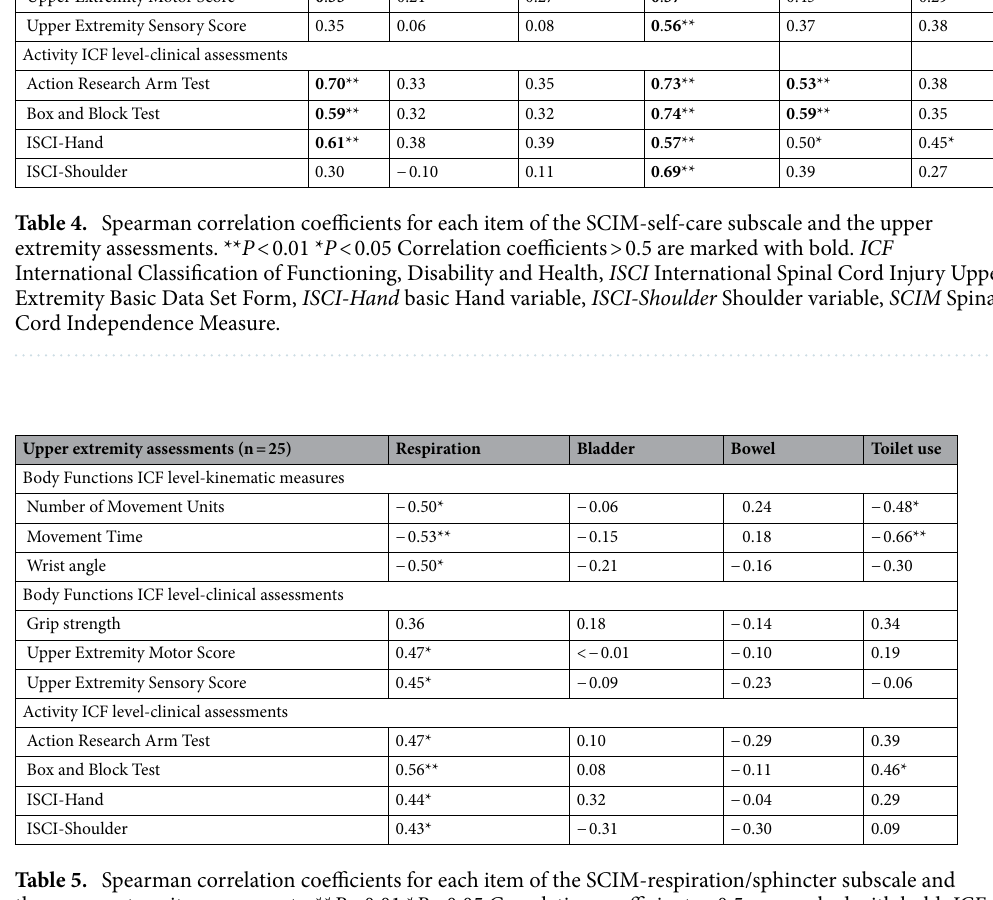
Table 5. Spearman correlation coefficients for each item of the SCIM-respiration/sphincter subscale and the upper extremity assessments. ** P < 0.01 * P < 0.05 Correlation coefficients > 0.5 are marked with bold. ICF International Classification of Functioning, Disability and Health, ISCI International Spinal Cord Injury Upper Extremity Basic Data Set Form, ISCI-Hand basic Hand variable, ISCI-Shoulder Shoulder variable.